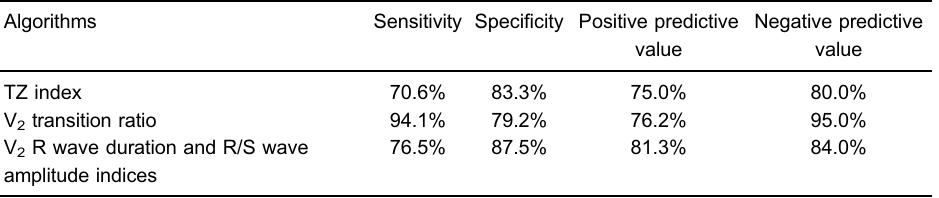
Table 4. Sensitivity, speci fi city, and positive and negative predictive values of the three algorithms in patients with rotation.